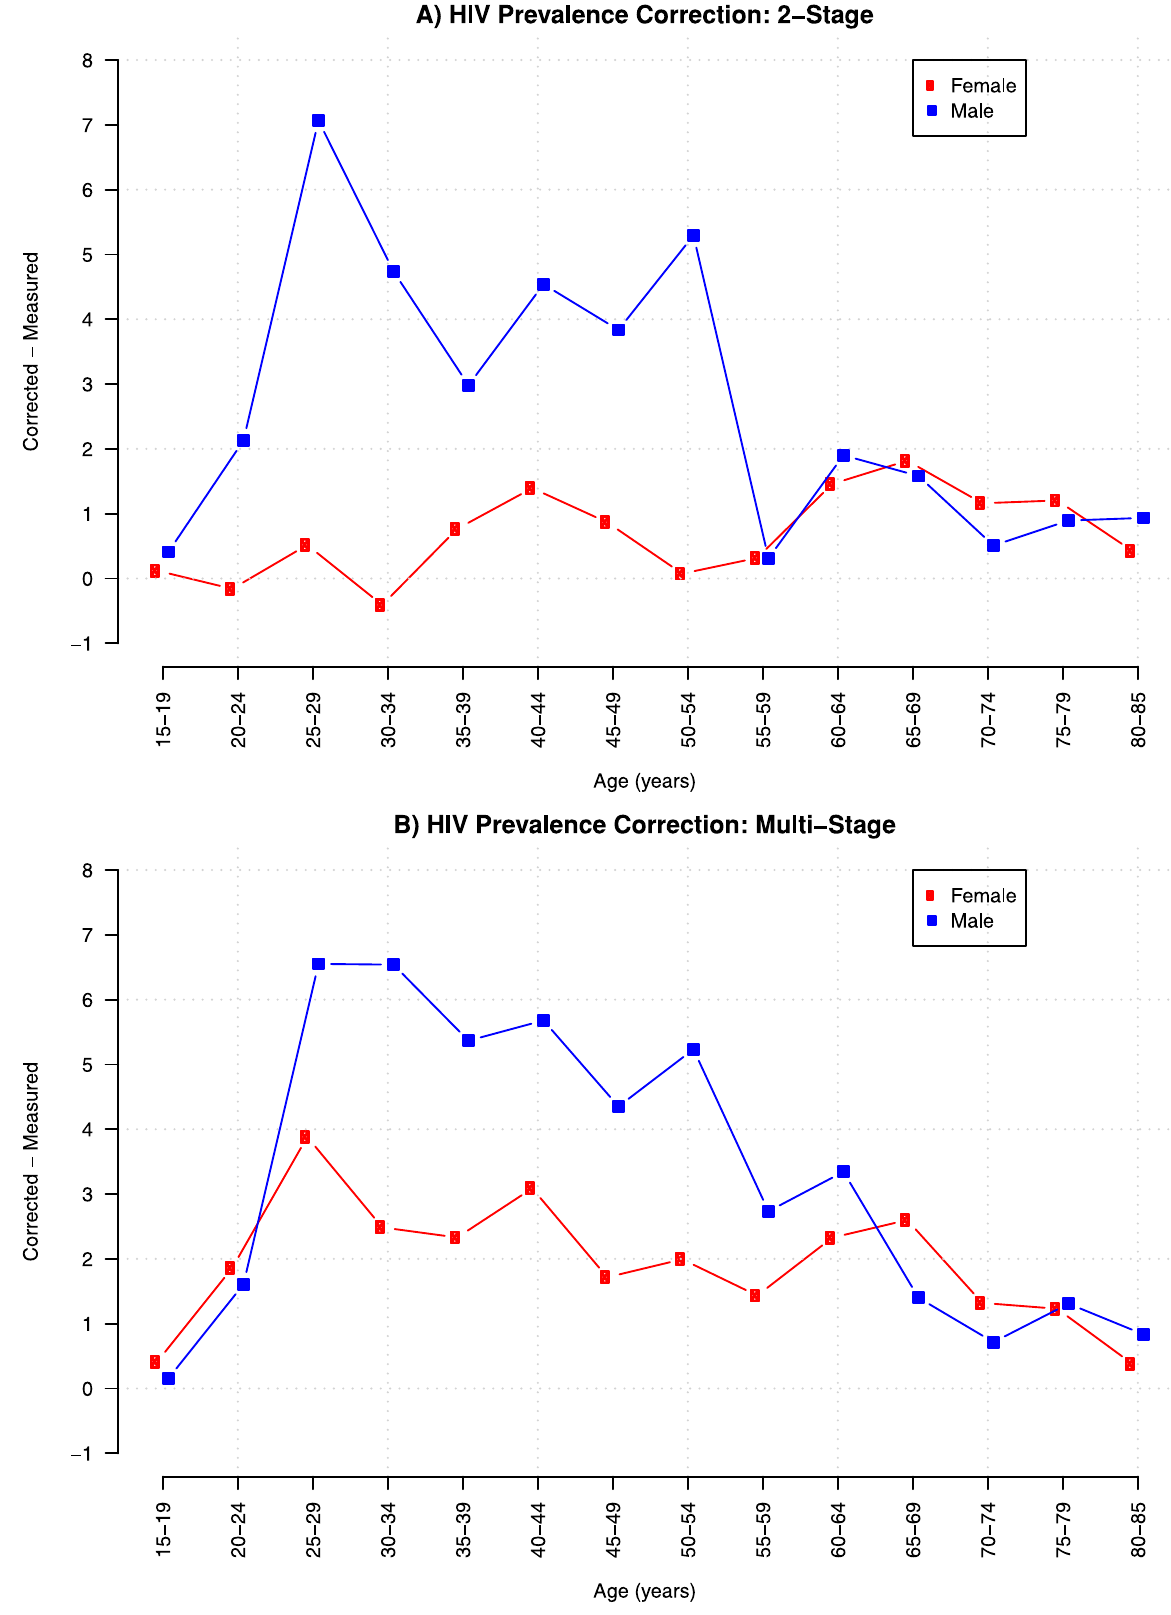
Figure 2. Corrections to sex-age specific Agincourt HDSS HIV prevalence, 2010 – 2011. A) Corrections using 2-stage approach; B) Corrections using multi-stage approach. doi:10.1371/journal.pone.0112563.g002 PLOS ONE |